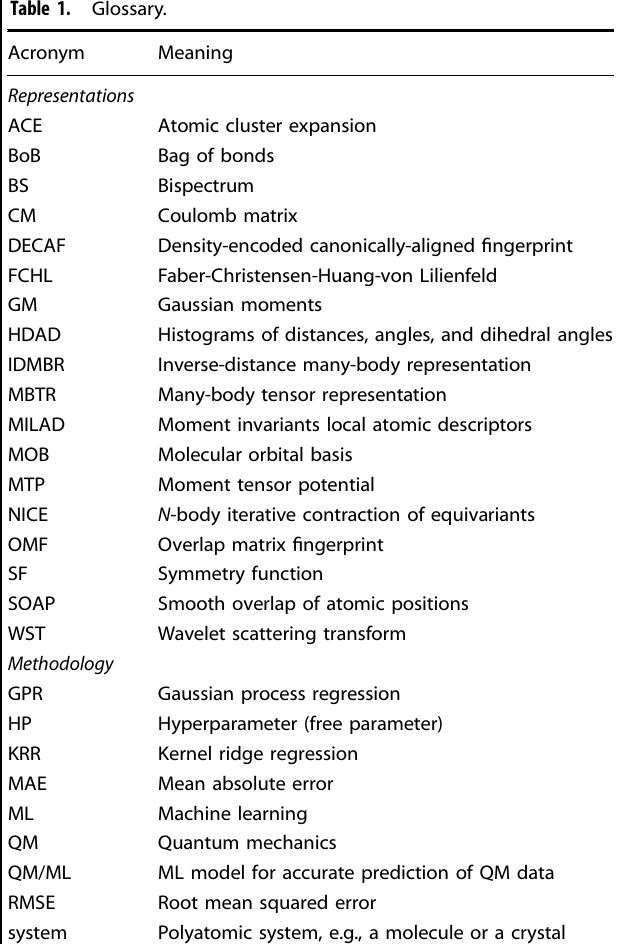
Finite systems: study uses datasets of fi nite systems, such as molecules or clusters; Periodic systems: uses datasets of periodic systems, such as crystalline materials; Other properties: evaluate properties other than energy or its derivatives; numerical/structural/regression HPs: whether numerical hyperparameters of representations, structural hyperparameters of representations, or regression hyperparameters are optimized